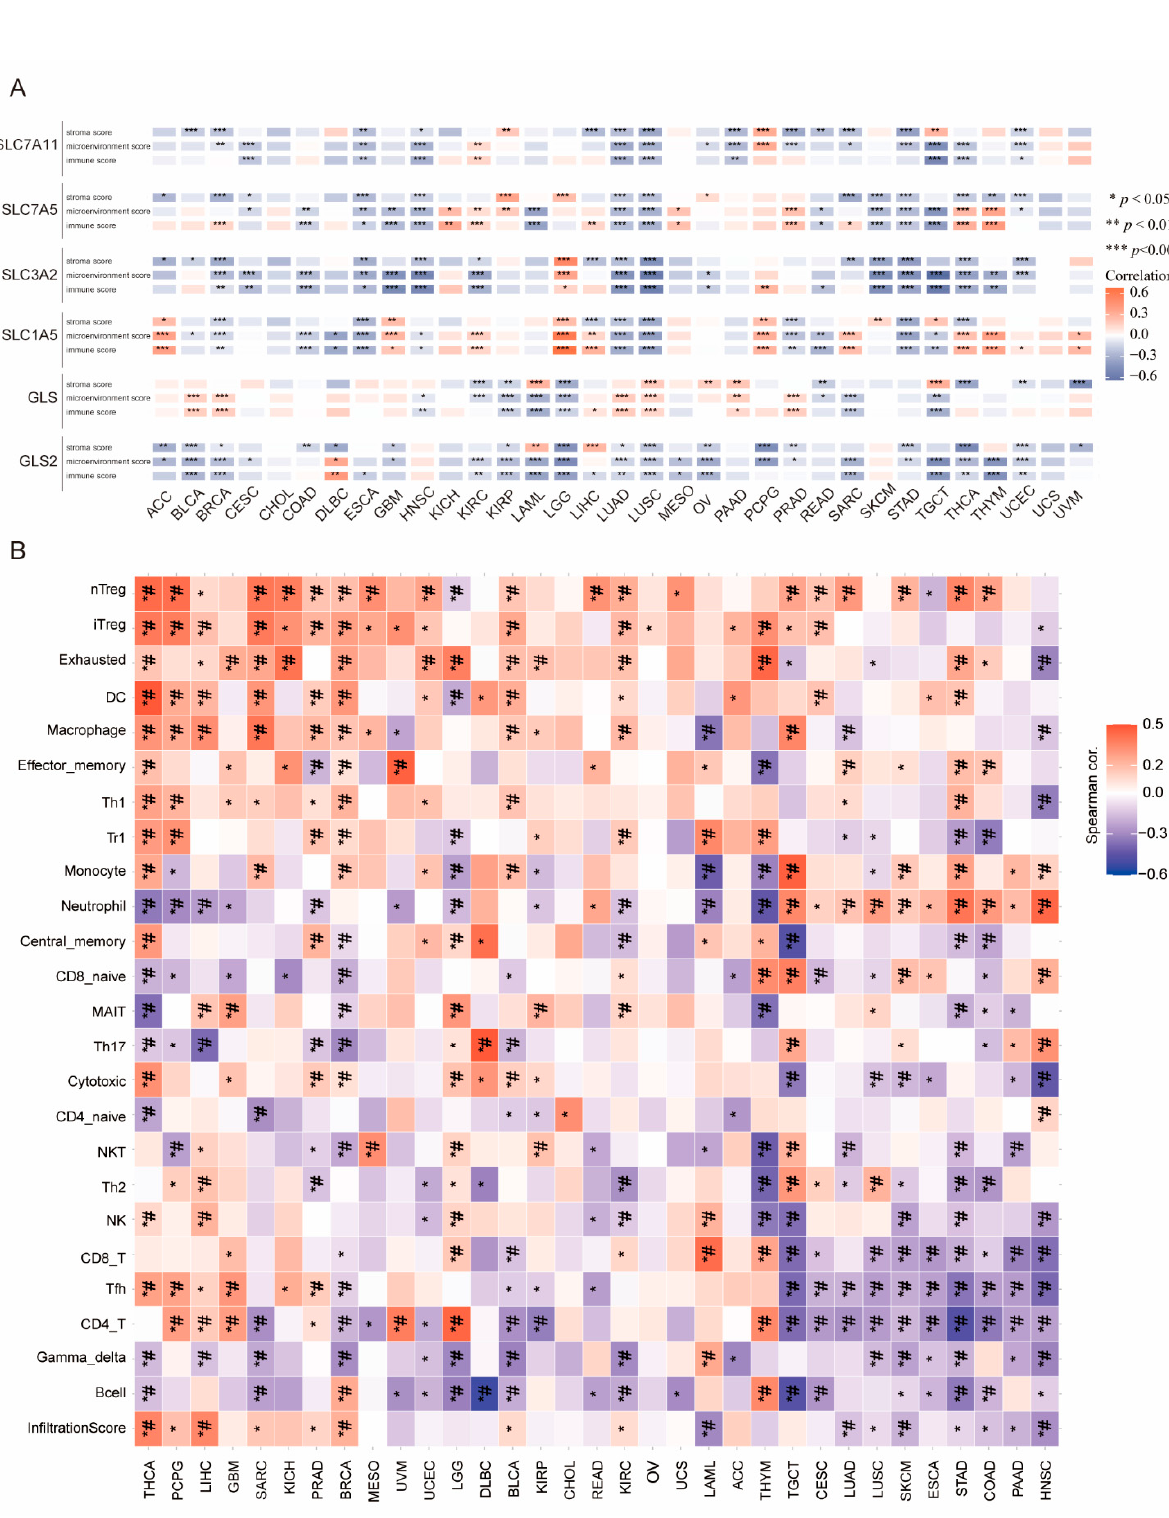
Figure 6. Associations between glutamine metabolism (GLNM) regulator expression and the tumor microenvironment: ( A ) heatmap displaying the correlations between GLNM regulator expression and immune scores, stroma scores, and microenvironment scores; ( B ) the relationship between GLNM regulators expression and immune cell infiltration. Blue represents negative correlations and red represents positive correlations. Note: * p < 0.05, ** p < 0.01, *** p < 0.001, # FDR < 0.05.